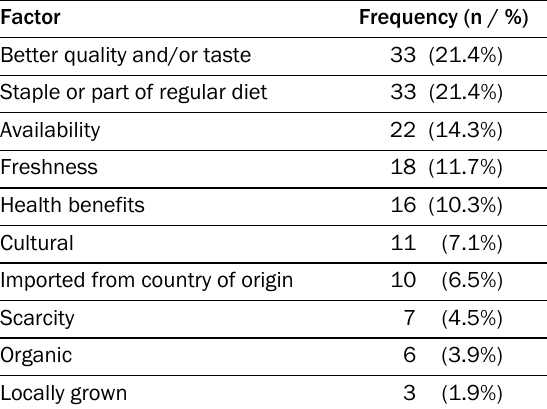
Table 6. Factors That Can Make